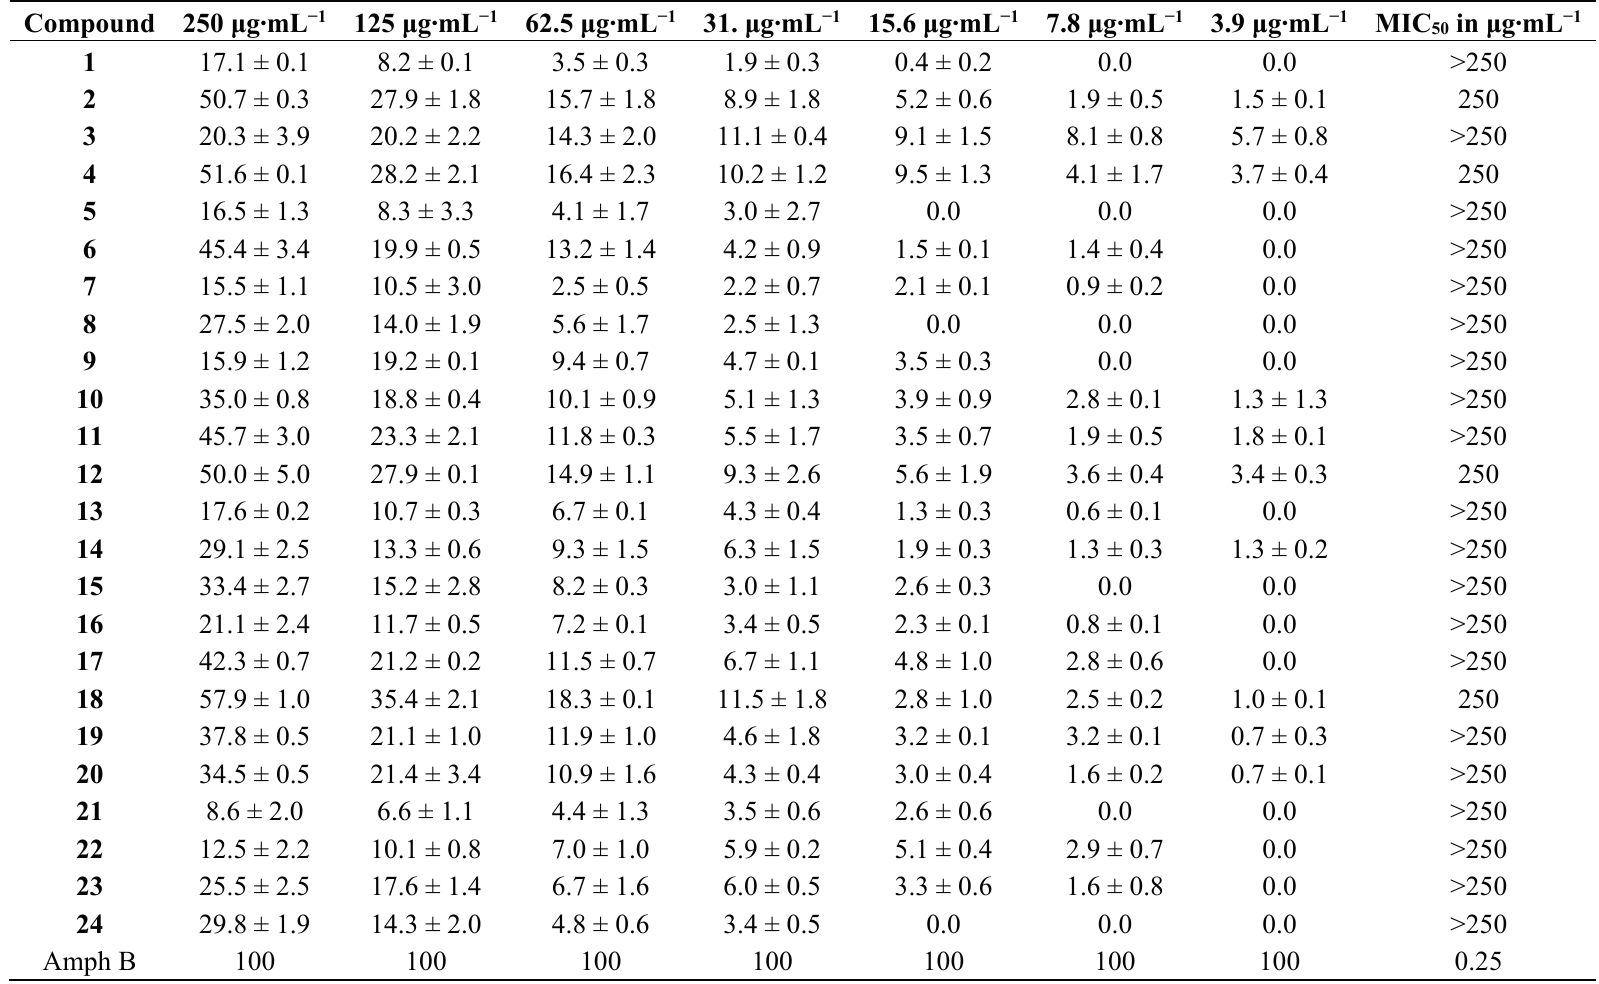
Table 2. Inhibition percentages displayed by 1 – 24 against C. albicans ATCC 10231 at the concentrations range 250–3.9 μ g·mL − 1 . The minimum concentrations of all compounds necessary to inhibit 50% of fungal growth (MIC 50 ) were included in the table. Standard drug: amphotericin B (Amph